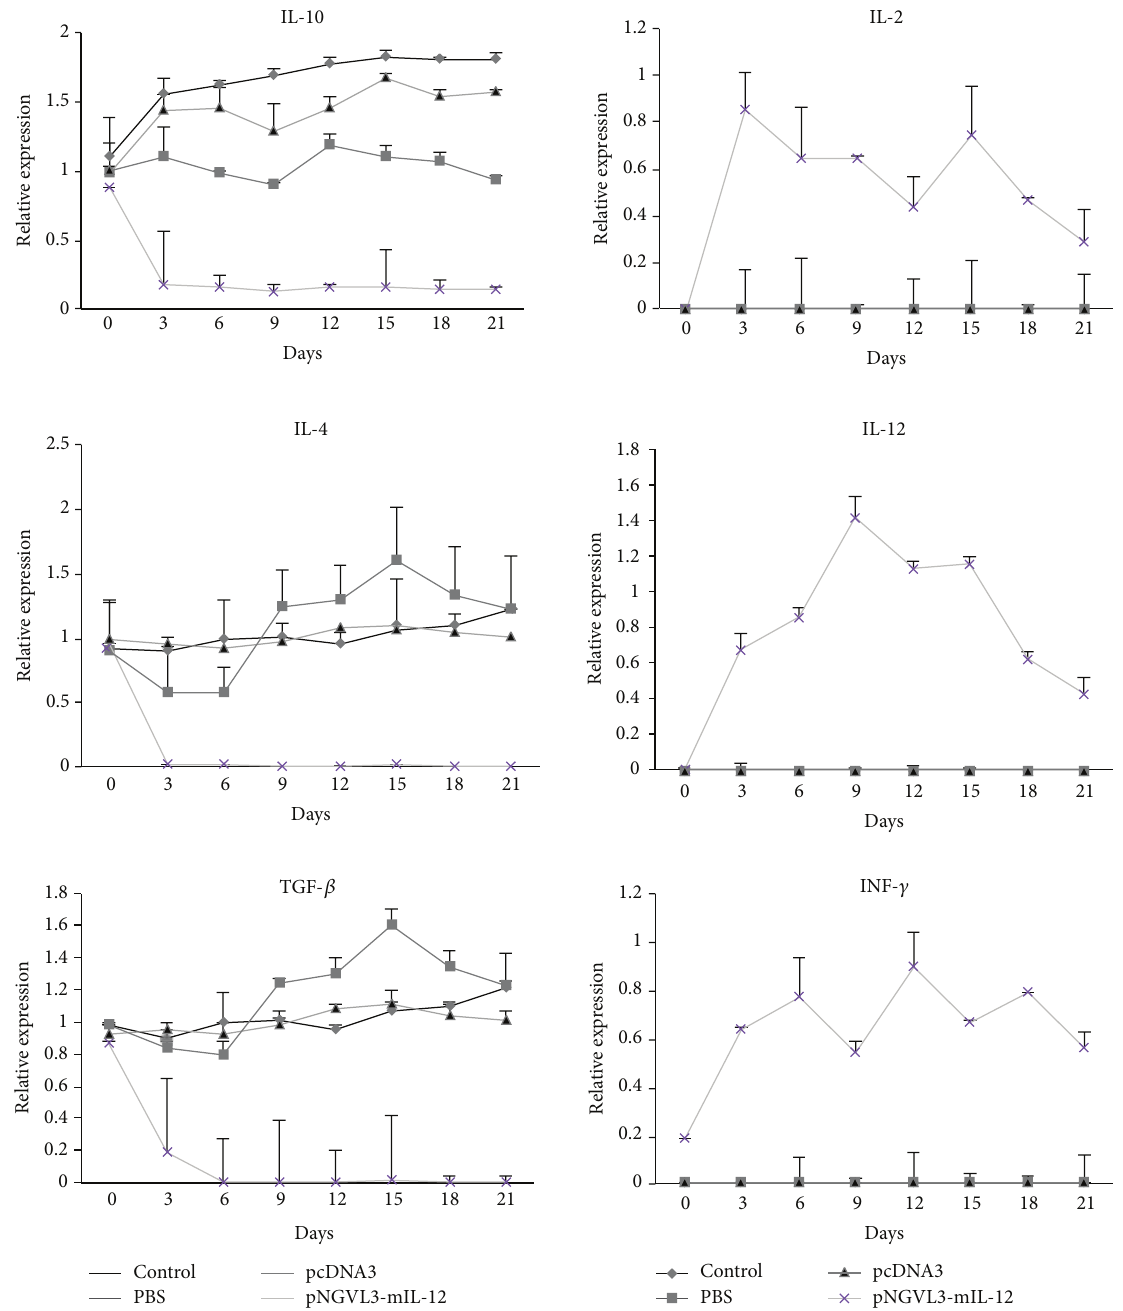
Figure 3: Intratumoral expression levels of cytokines mRNA. An experimental tumor model was generated and treated with the IL-12 gene expression plasmid (asterisks), pcDNA3 plasmid (triangle), PBS (square), or no treatment as control (diamond). Every three days following treatment the mice were sacrificed, the total RNA was extracted, and the cytokines expression profile was determined with by real time RT- PCR. Th2-Th3-type cytokine profiles and no expression of Th1-tye cytokines were detected in the tumor-bearing mice prior to the treatment. A significantly lower expression of Th2-/Th3 cytokines and higher expression of Th1 cytokines were detected after the treatment with IL-12. Results represent the means ± S.E. values of cytokines expression in each 5-mouse group, 𝑃 < 0.001